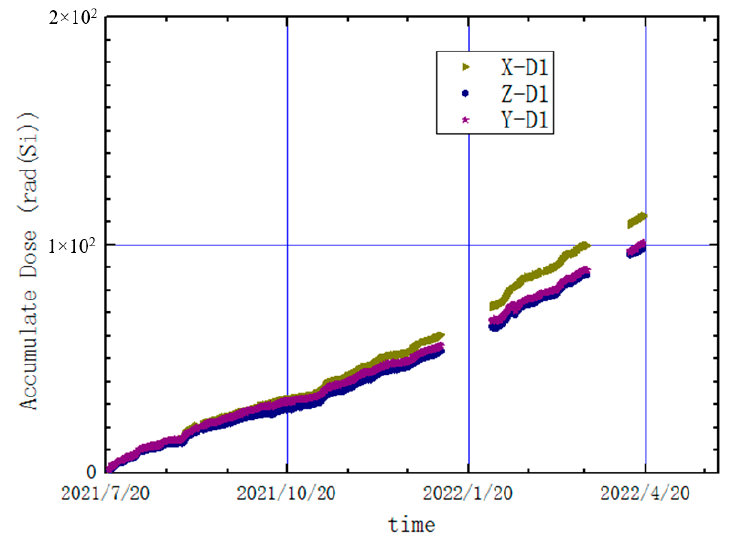
Figure 8. Cumulative dose results of the three dose detectors at monitoring point D1.